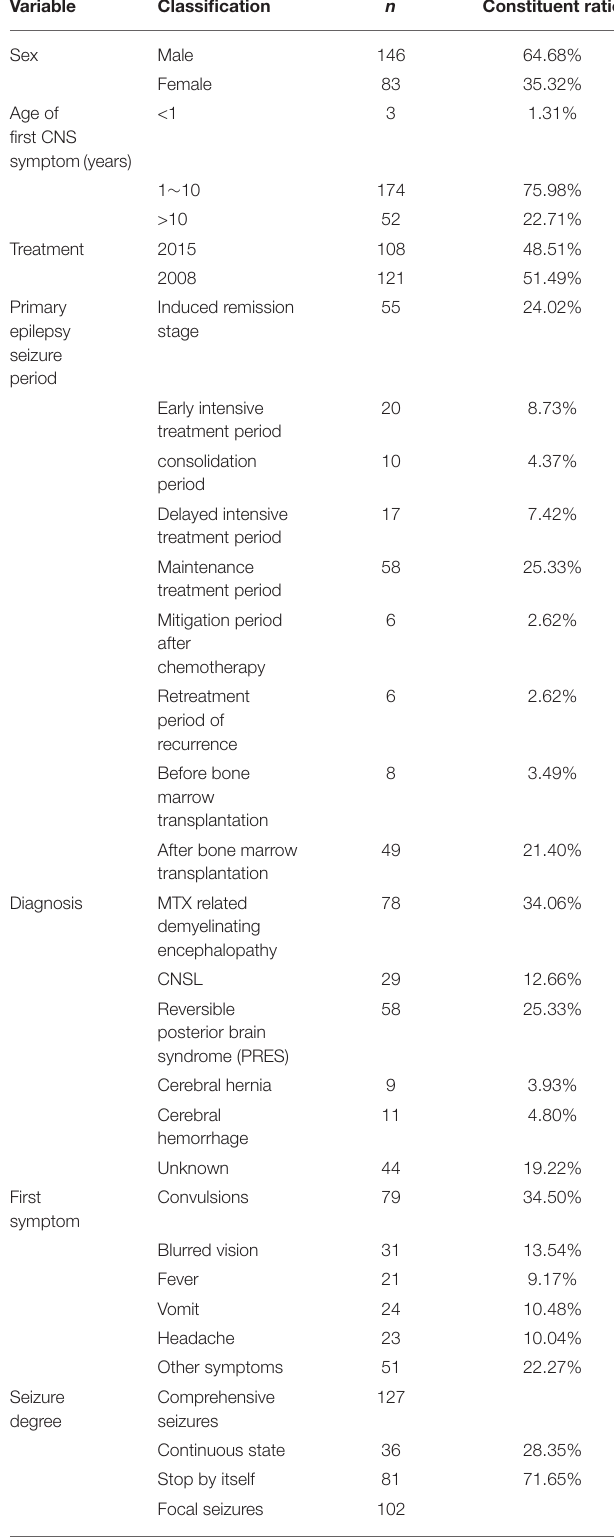
TABLE 1 | Clinical characteristics of primary epilepsy seizure in ALL